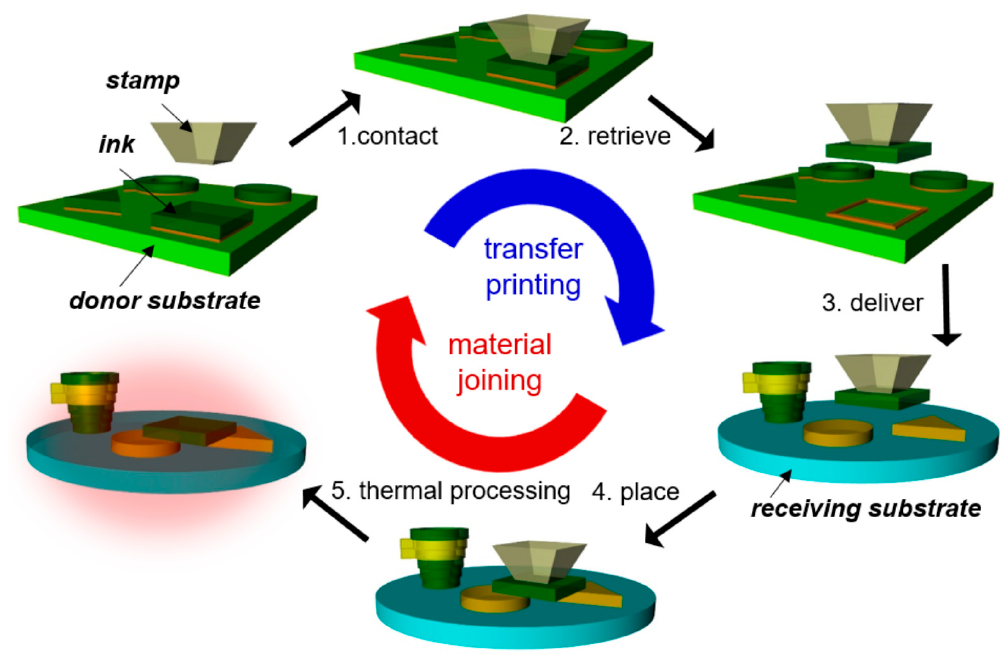
Figure 1. Micro-LEGO procedure, including transfer printing and material joining.